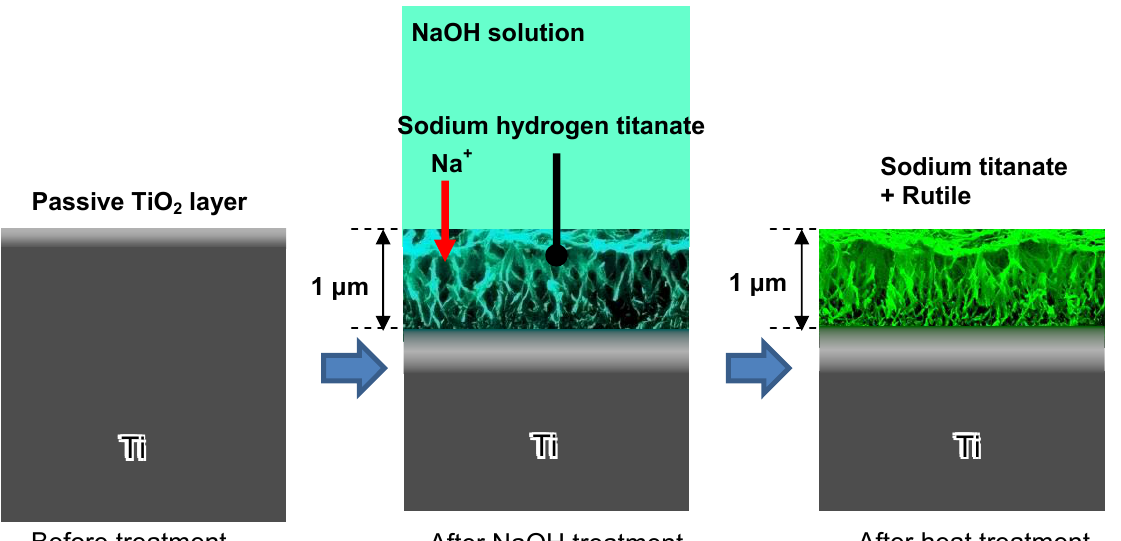
Figure 4. Structural change of surface of Ti metal subjected to NaOH and heat treatments.